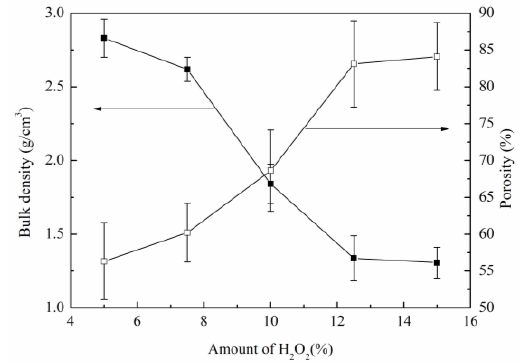
Figure 4. Effects of H 2 O 2 additions on porosity and bulk density of SiC porous ceramics.